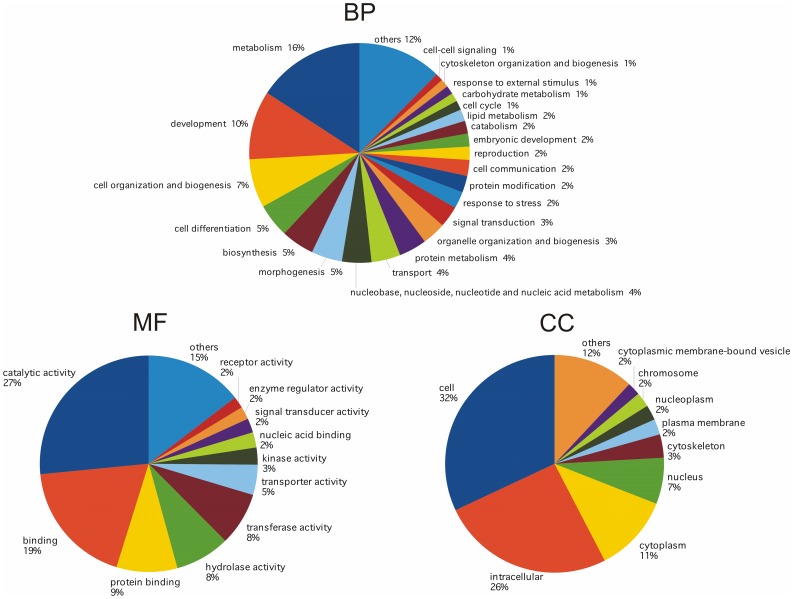

Chamelea gallina transcriptome functional annotation based on Blast2GO analysis.Functional annotation results indicate the relative amount of each category of contigs with protein hits. The results are summarized as follows: Biological Process (BP), Molecular Function (MF) and Cellular Component (CC).